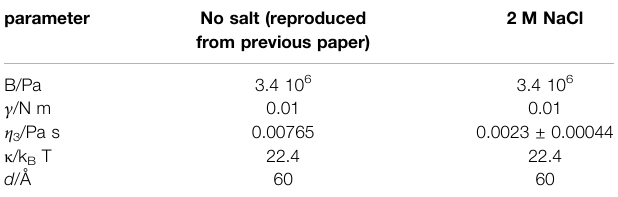
TABLE 2 | Parameters used to calculate curves for the GINSES description. Only viscosity is fi tted. Within the errorbars, the remaining parameters returned to the given values taken from the previous